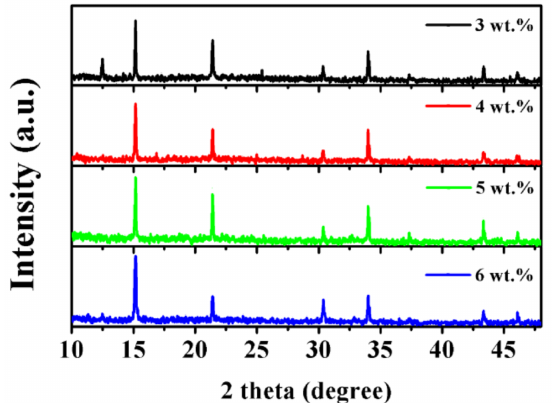
Figure 3. X-ray diffraction patterns of the MAPbBr 3 film.